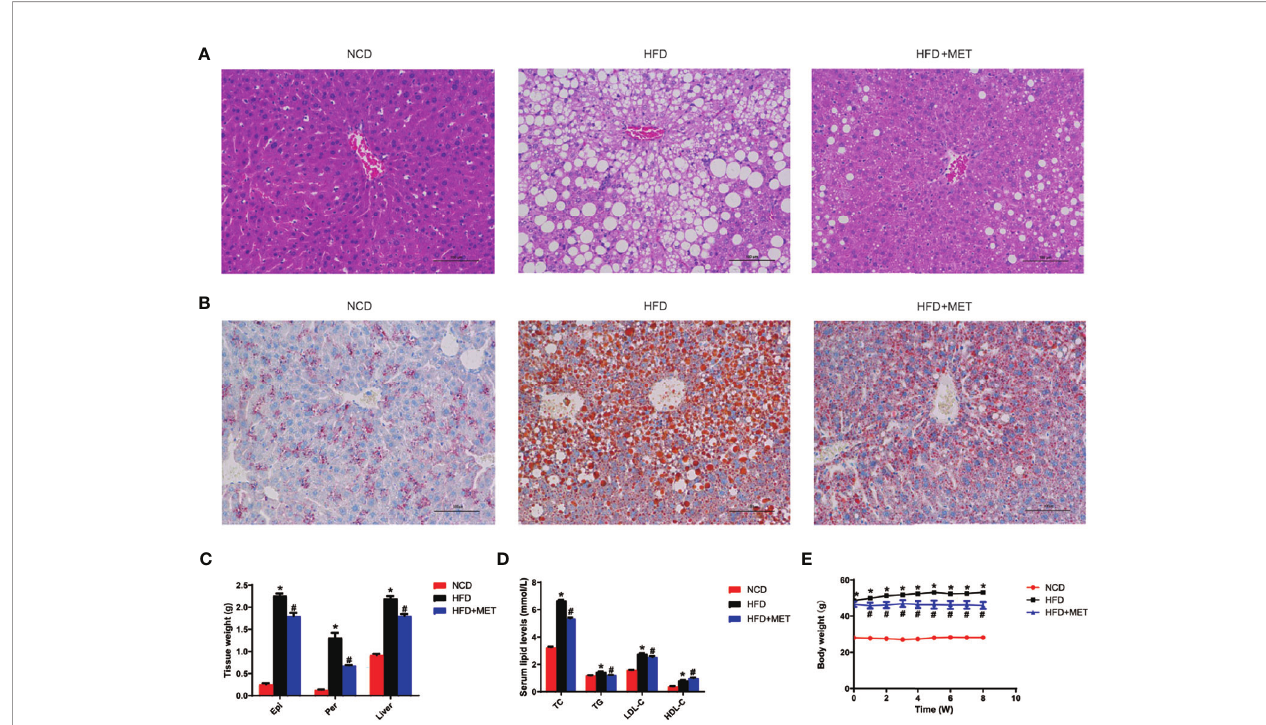
FIGURE 1 | Inhibition of hepatic steatosis, hyperlipidemia, and obesity by MET. (A) Liver hematoxylin and eosin (H&E) staining. (B) Liver oil red O staining, ×200 (scale bars, 100 m m). (C) Tissue weight of perirenal fat, epididymal fat and liver after 8 weeks of treatment. (D) Serum lipid levels after 8 weeks of treatment. (E) Curve of body weight change from 0 to 8 weeks of treatment. The MET treatment was administrated for 8 weeks in HFD mice after 16 weeks on high-fat diet. Data are presented as the mean ± SEM (n = 10). * P < 0.05 HFD versus NCD, # P < 0.05 HFD+MET versus